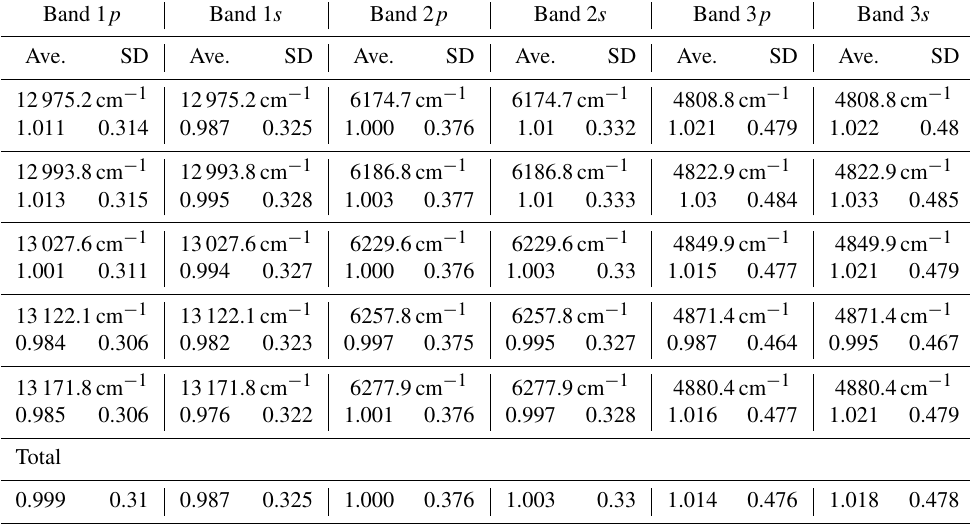
Table 7. Ratio of radiances between TANSO-FTS and TANSO-FTS-2 in the SWIR region.